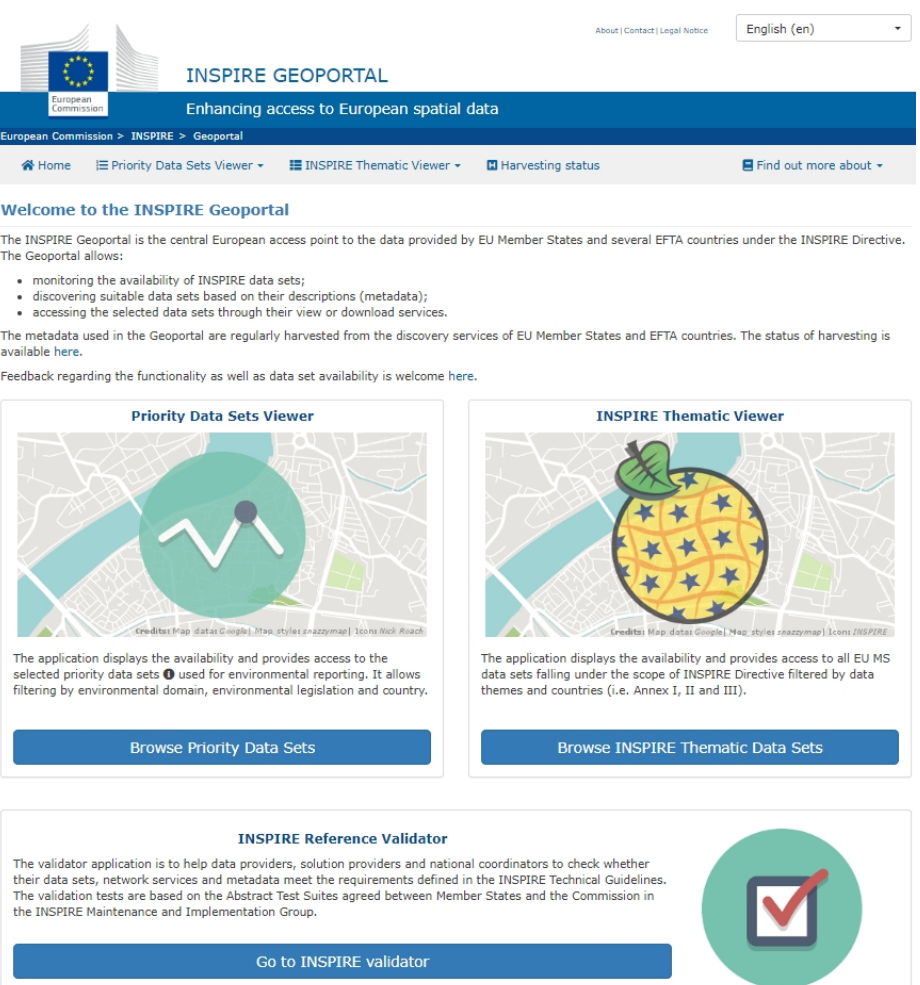
Figure 5. Landing page of the INSPIRE Geoportal. Source: European Commission, Joint Research